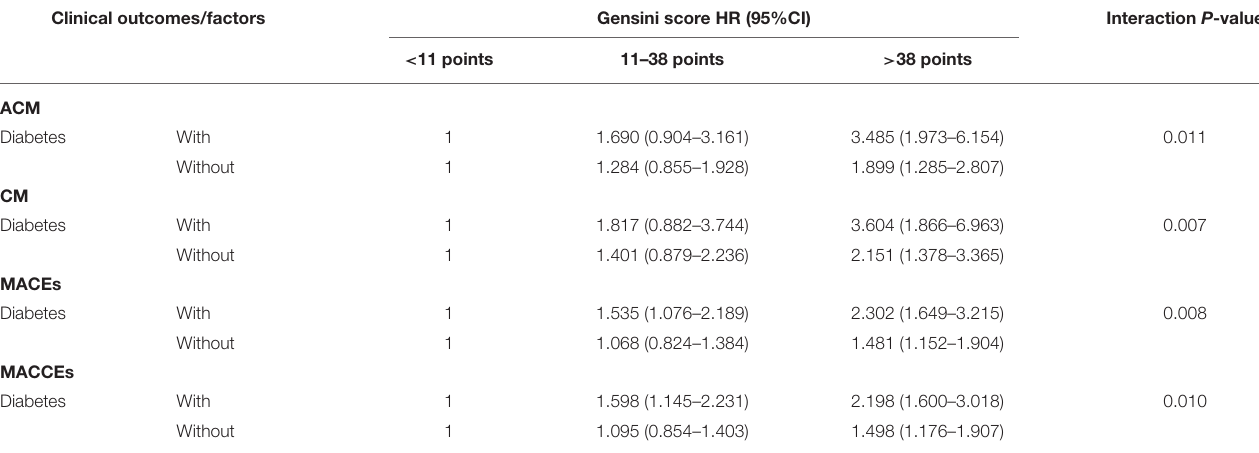
TABLE 5 | Cox regression stratified analysis of Gensini score and the risk of ACM, CM, MACEs, MACCEs. Clinical